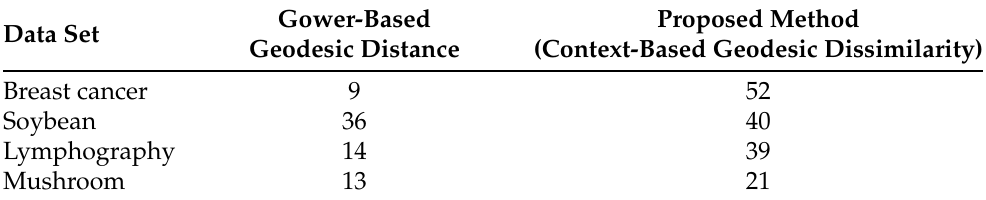
Table 5. Smallest k with the largest Rand index.